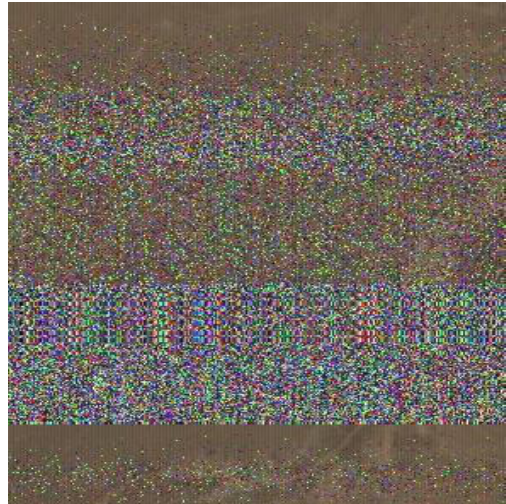
Bad Quality Figure 2 AWiFS image corrupted with impulse noise as shown on NRSC UOPS website with quality indication